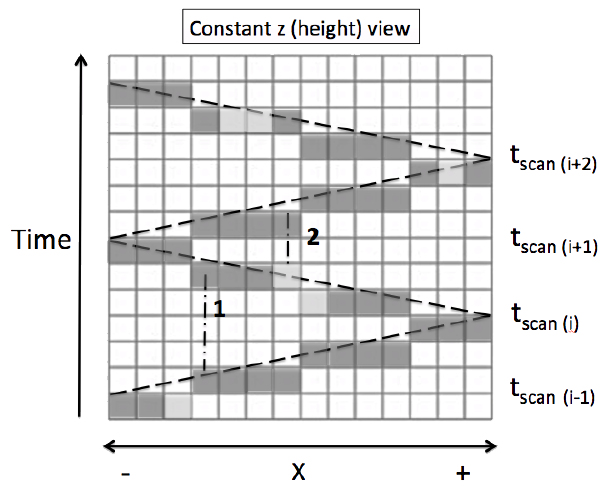
Fig. 4. Schematic of the consecutive CW-RHI scans at constant height. Scenario 1: neighboring scans contain cloud (dark squares). Scenario 2: previous scan does not contain cloud (light squares) and the next scan contains